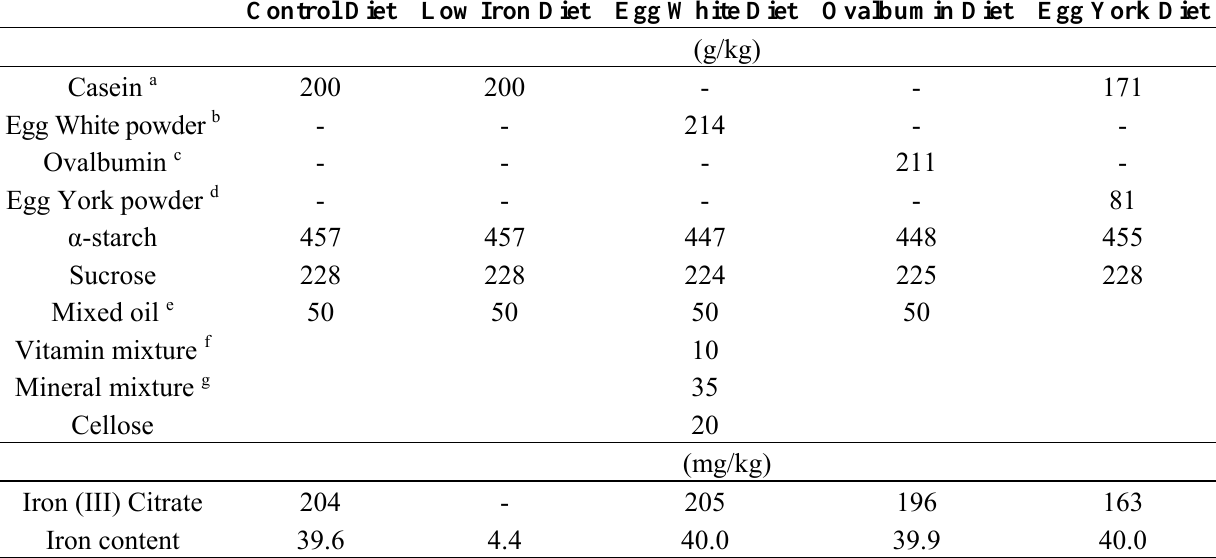
Table 1. Composition of experimental